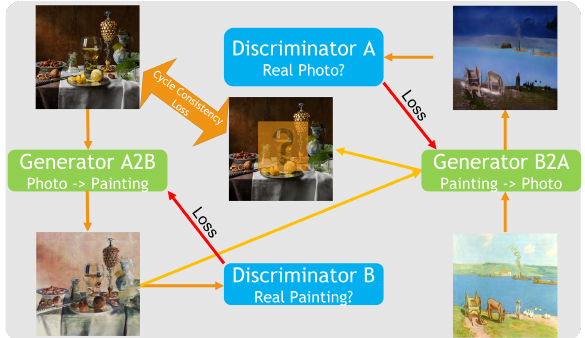
Figure 2. CycleGAN network structure.